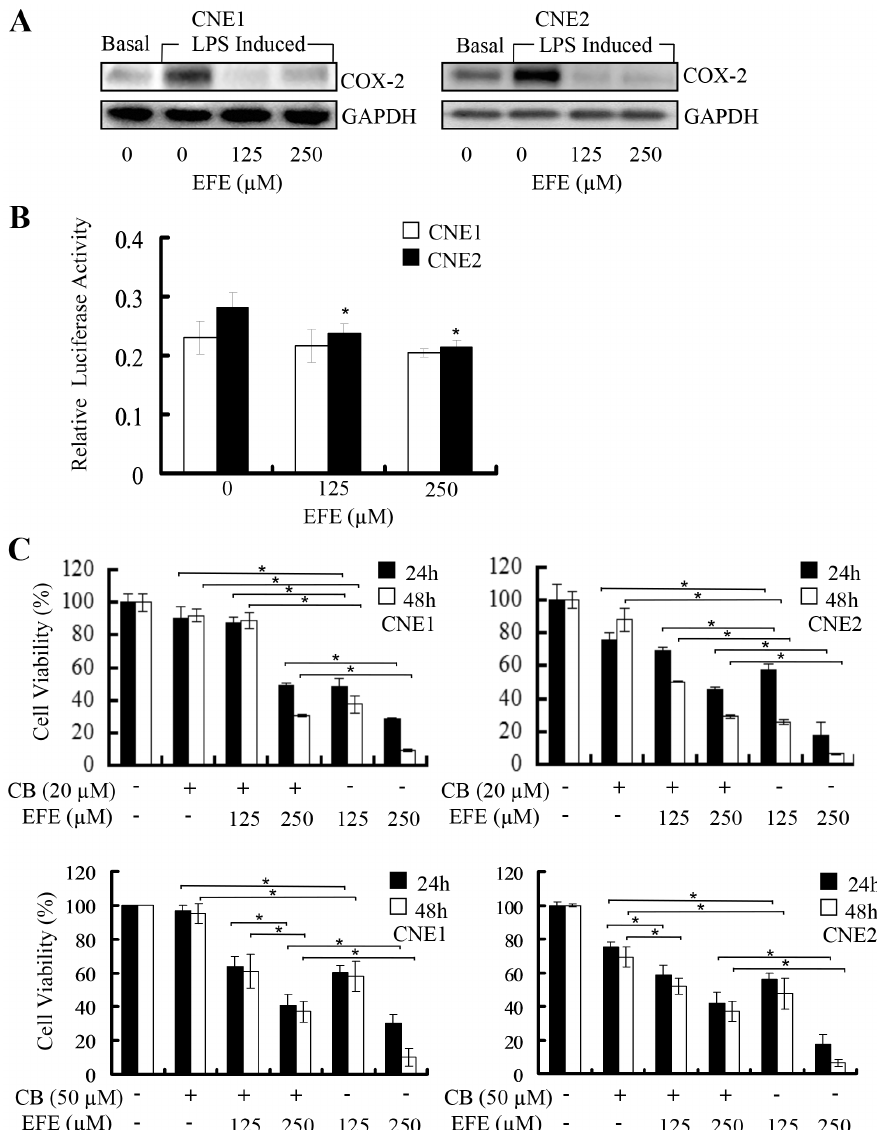
Figure 4. Effusanin E affects activity of the COX-2 pathway. ( A ) NPC cells were pretreated with lipopolysaccharides (LPS) (2 m g/ml) for 8 hours then treated with effusanin E at 125 m M and 250 m M (EFE 125 m M or EFE 250 m M). At 24 hours after treatment, COX-2 protein expression was determined by western blotting. ( B ) NPC cells were transfected with a luciferase expression vector containing a COX-2 5-flanking fragment for 8 hours and treated with effusanin E (EFE) at the indicated doses. At 24 hours after treatment, COX-2 promoter activities were determined. ( C ) The effect of effusanin E was inhibited by an inhibitor of COX-2 in NPC cells. NPC cells were treated with celecoxib (CB) (20 m M or 50 m M) for 8 hours followed by effusanin E at 125 m M and 250 m M (EFE 125 m M or EFE 250 m M) for up to 24 hours or 48 hours. At the indicated time points, the cells were analyzed using the MTS assay. The data are presented as the mean 6 S.D. of three separate experiments. * represent P , 0.05. doi:10.1371/journal.pone.0109951.g004 ponicidin (two 7,20-epoxy- ent -kaurenoids), xindongnin A and xindongnin B (two C-20-nonoxygenated- ent -kauranoids) could be